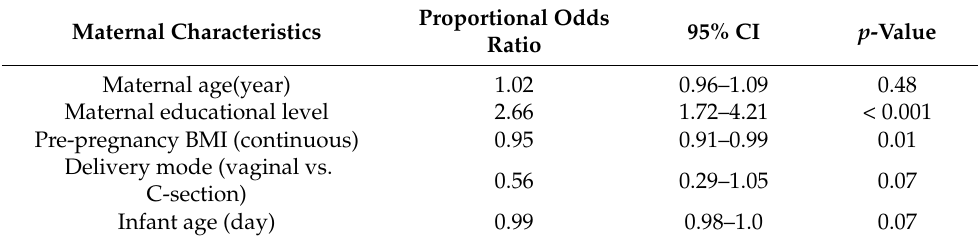
Table 2. Association between breastfeeding (exclusive, partial, and no breastfeeding) and perinatal characteristics 1